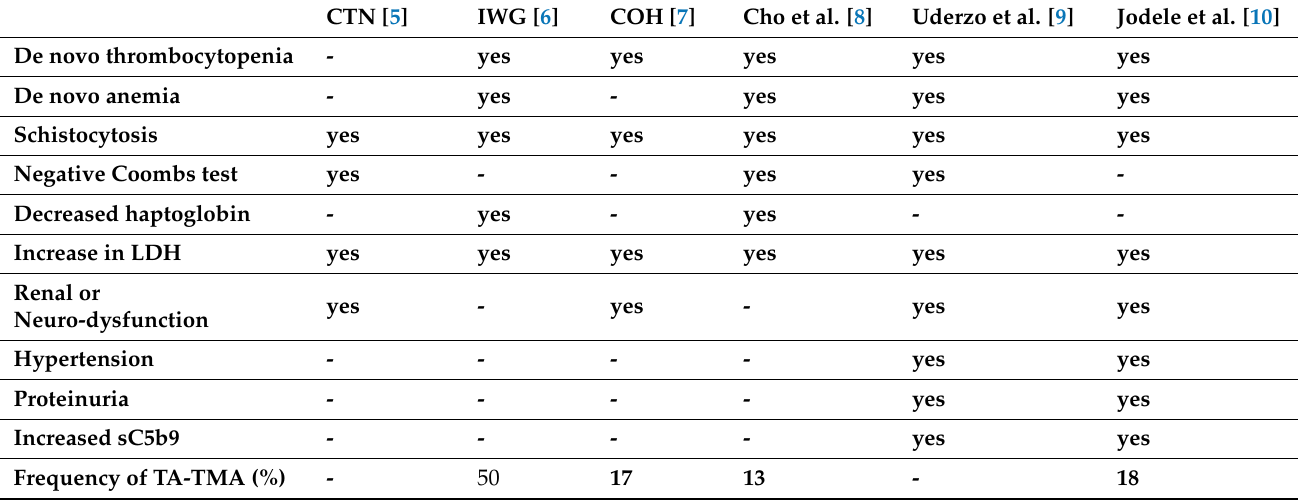
Table 1. Different diagnostic criteria for transplant-associated thrombotic microangiopathy (TA-TMA) and the corresponding reported